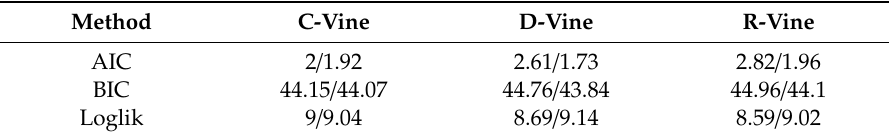
Table 6. AIC, BIC, and Log-likelihood for C-, D-and R-vine. The data before “ / ” represent the AIC, BIC, and Log-likelihood values in the period of B-IRSN, and the data after “ / ’ represent the AIC, BIC, and Log-likelihood values in the period of A-IRSN.